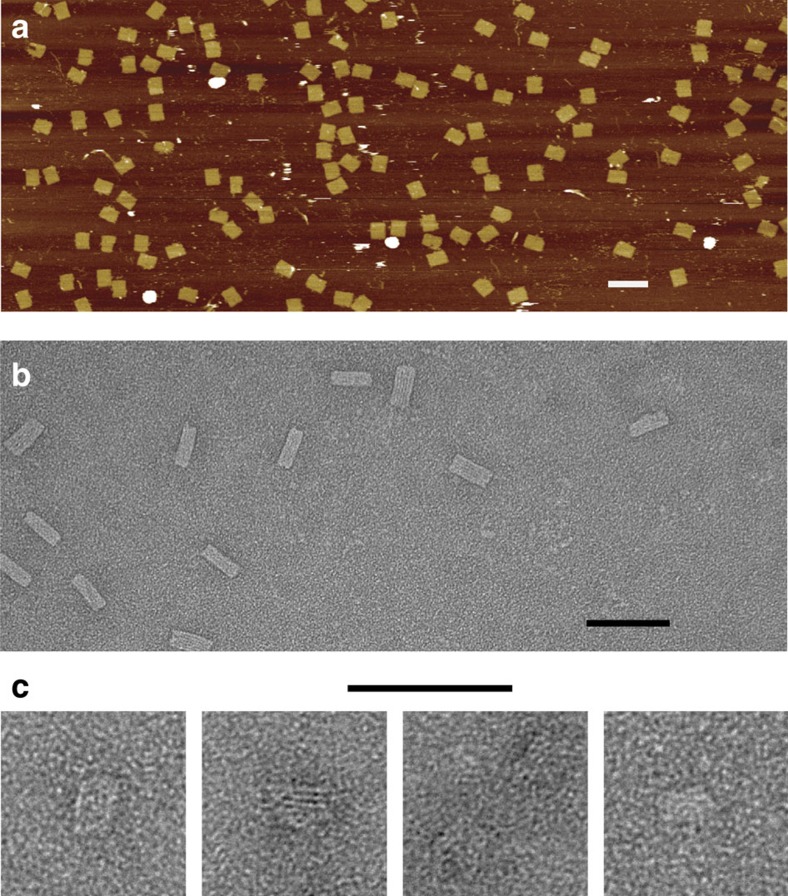
Structures folded from oligonucleotides amplified by circle-to-circle amplification.(a) An AFM image of a single-layer rectangular origami structure as in literature1. (b) A TEM image of a multilayer three-dimensional origami structure. (c) A small scaffold-free three-dimensional ‘DNA-brick'5 structure. Scale bars in a,b, 100 nm; in c, 50 nm. Panel a was folded with oligonucleotides from Fig. 3 lane 6; b with Fig. 3 lane 4.